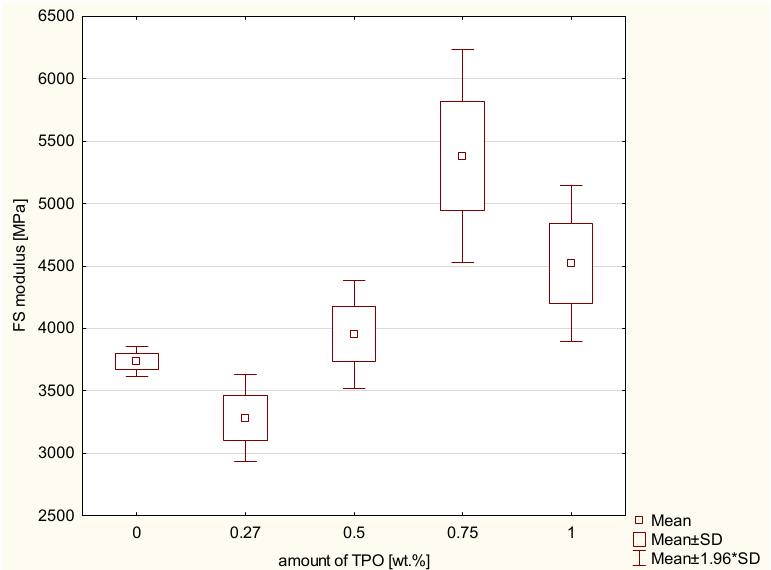
Figure 4. Box-and-whisker plot of s of the modulus of elasticity in bending (FS modulus) [MPa] between composites with different photoinitiator systems; photopolymerization both side of samples 20 s per 2 mm thickness of composites with Valo lamp light intensity 1450 mW/cm 2 . The results of CIE L* a* b* color system are shown in Figures 5 and 6. There were three color measurements made for each composite. The values closest to the control group of CQ and DMAEMA on axis a* are connected with concentration of TPO. The higher the TPO concentration, the greater the distance between control group and re-